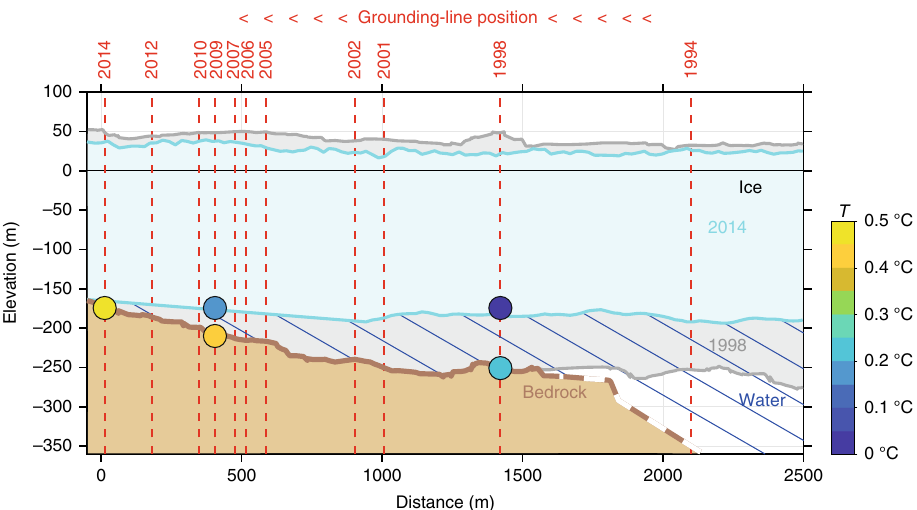
Fig. 6 Ice shelf geometry and water temperatures at Midgardsormen. Changes in ice shelf geometry in the Midgardsormen region between 1998 and 2014 and the location of the grounding line for the years with suitable satellite imagery. The water temperatures for the years of available CTD measurements are shown for the respective depth levels of the grounding line and a water depth of 175 m (grounding line depth in